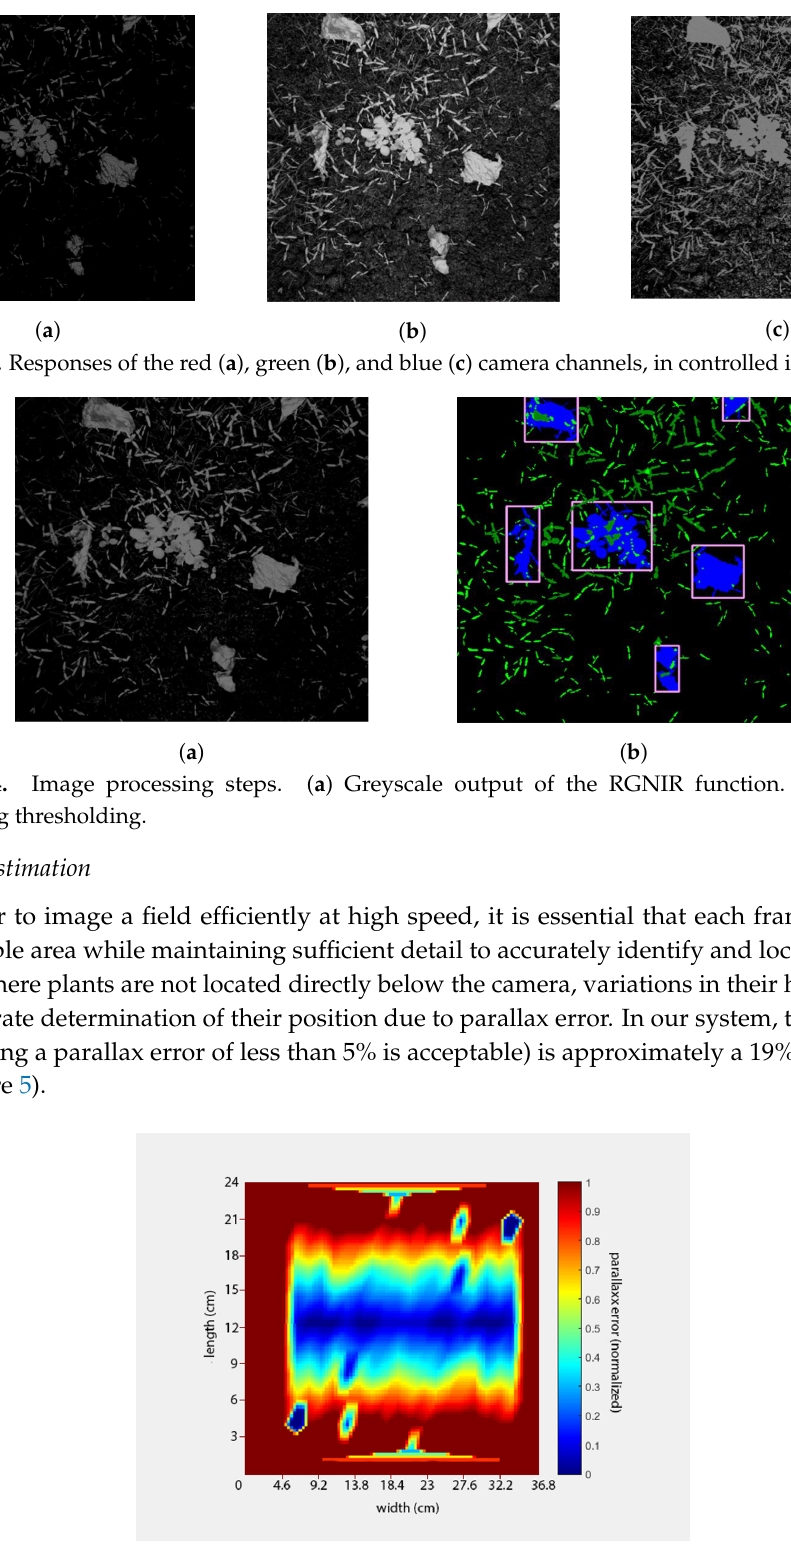
Figure 5. Heat map of the normalised position error across a